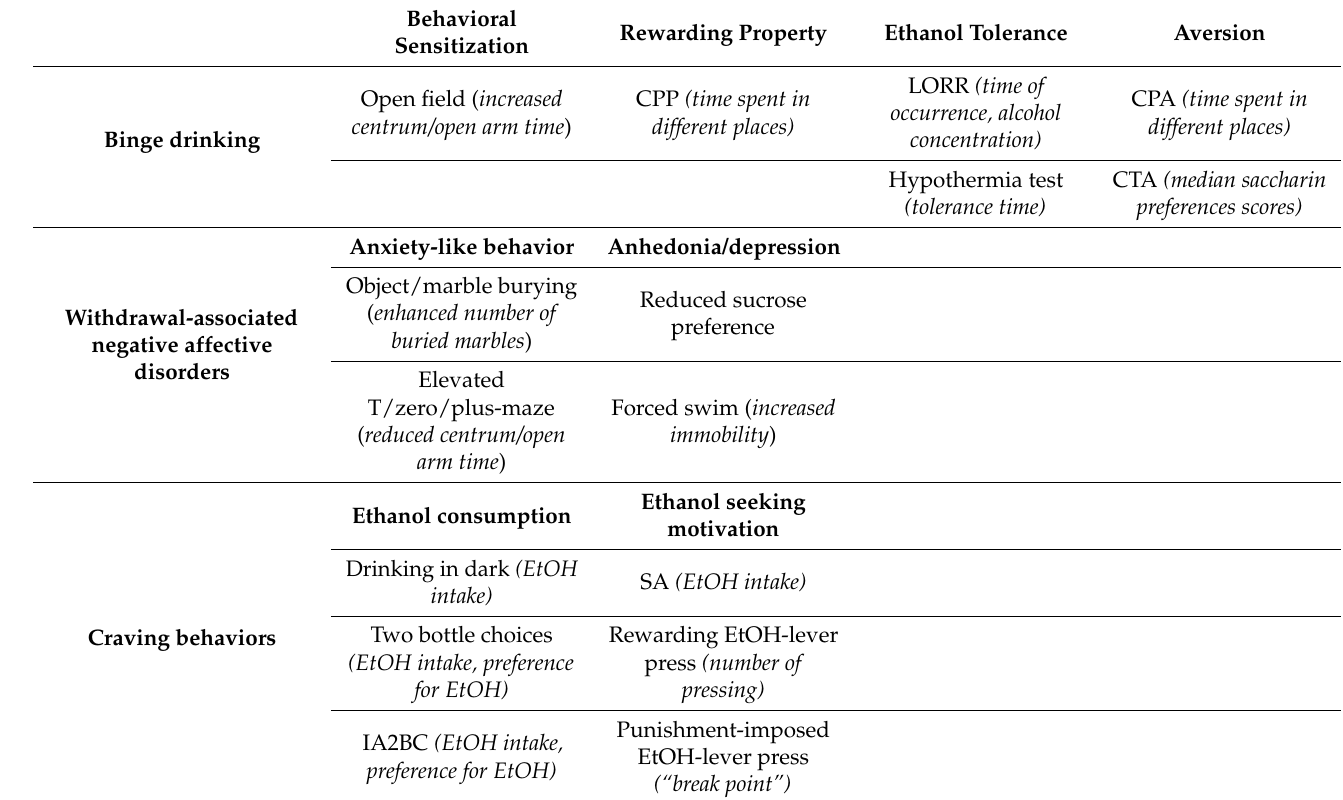
Table 3. Summary of tests used in animal models of